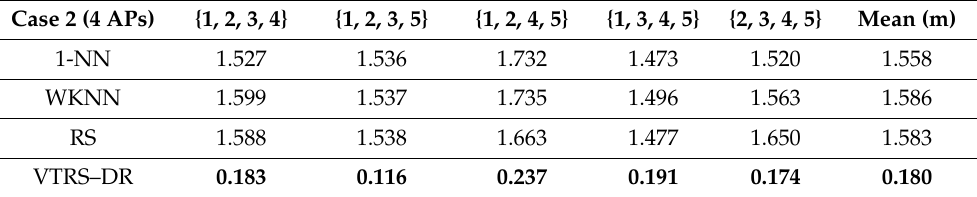
Table 9. Mean errors of using four APs in Case